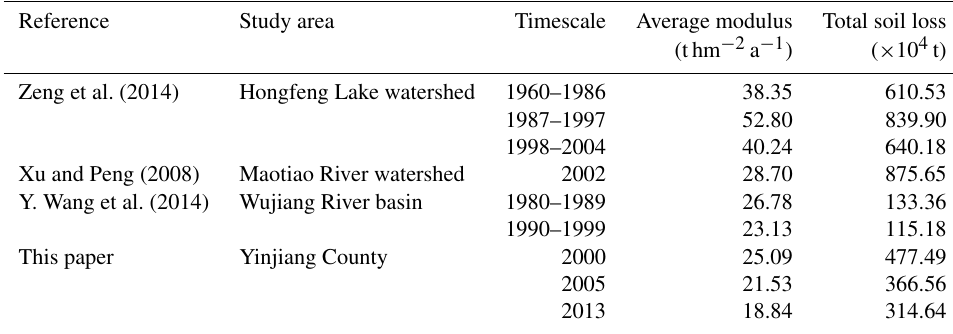
Table 7. Soil erosion data obtained in previous studies in typical karst